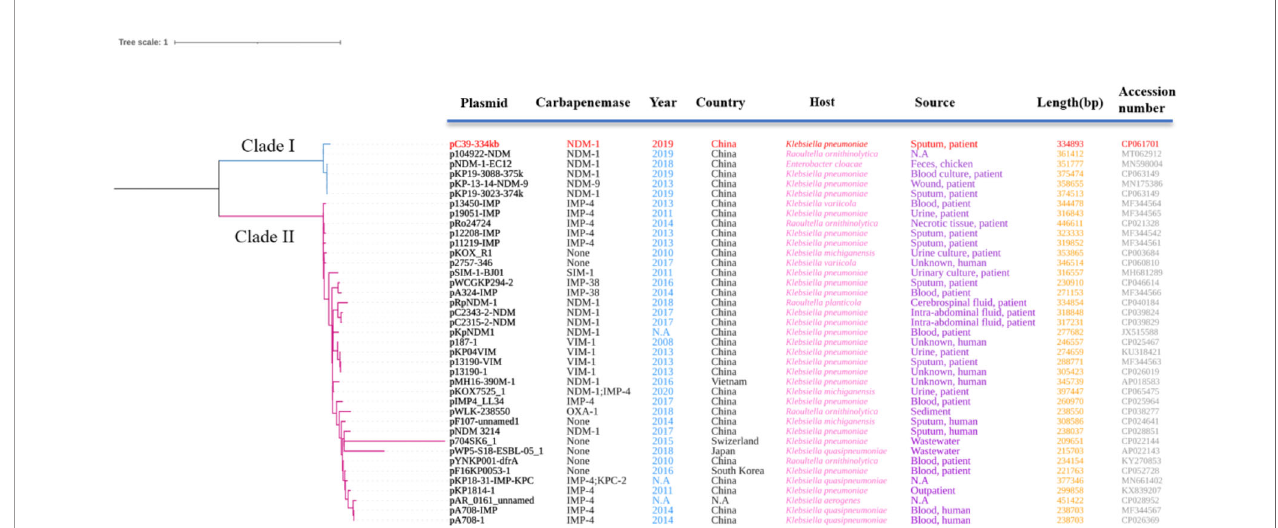
FIGURE 2 | Phylogenetic tree of 39 plasmids constructed based on recombination-free SNPs. Clade I includes pC39-334kb with the fi ve most homologous plasmids, among which pNDM-1-EC12 belongs to IncHI5 plasmids based on replicon genes. All plasmids contained in clade II are IncHI5 plasmids. The plasmid involved in this study is highlighted in red. N.A, not